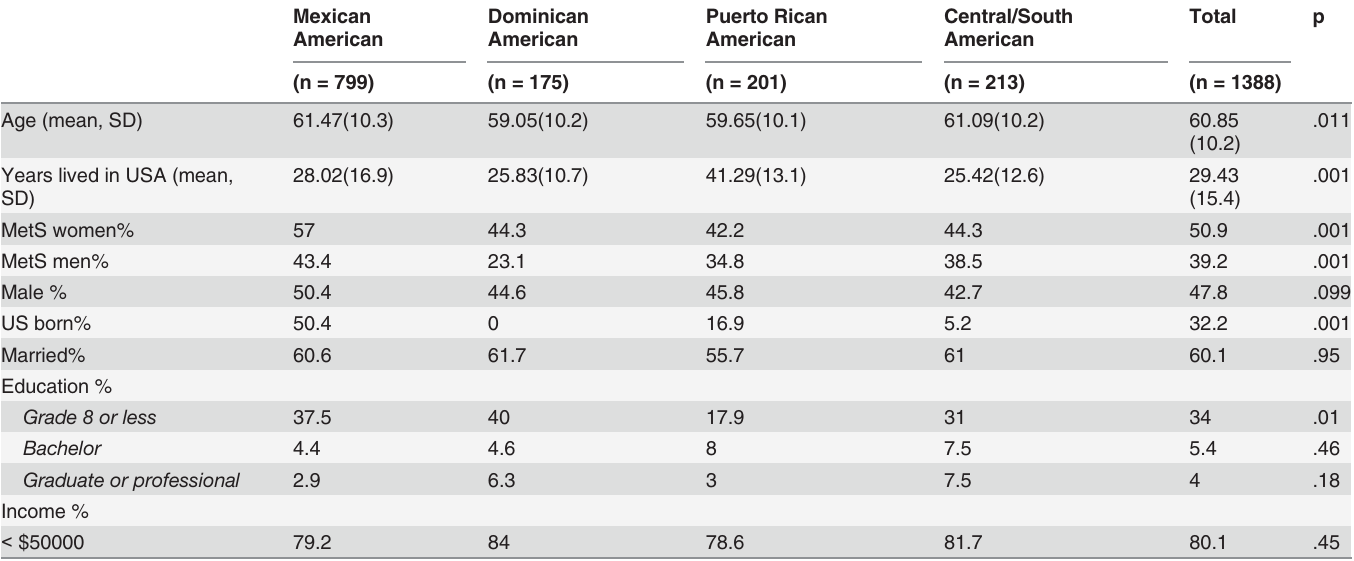
Table 1. Demographics